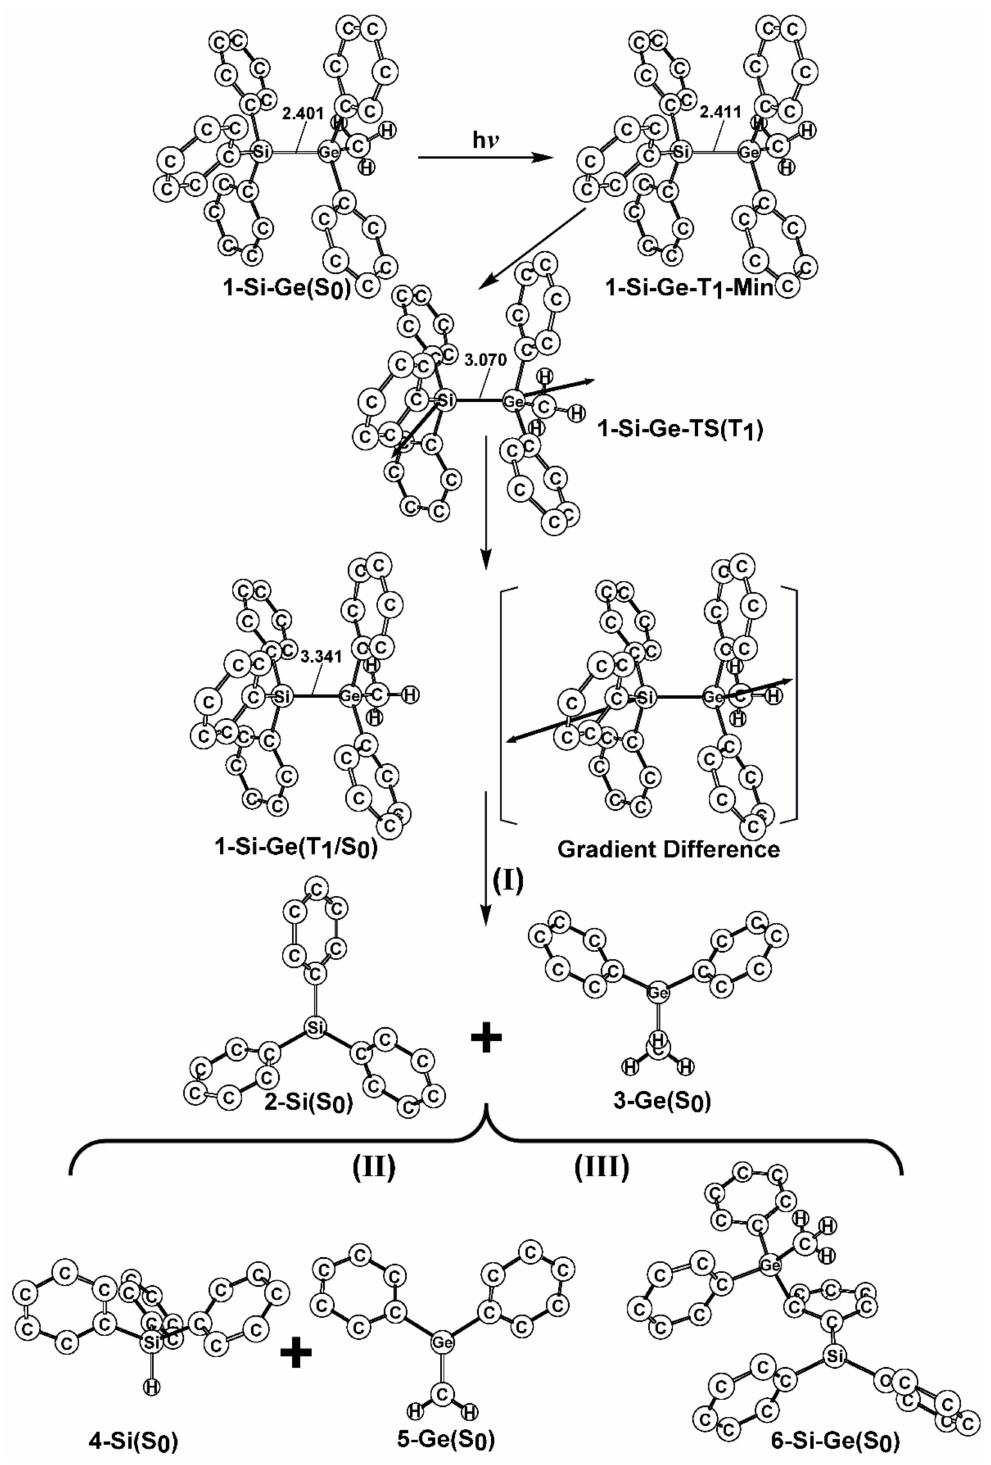
Figure 4. The optimized structures for the photochemical isomerization model of Ph 3 Si–GePh 2 Me at the M06-2X/6-311G(d) level of